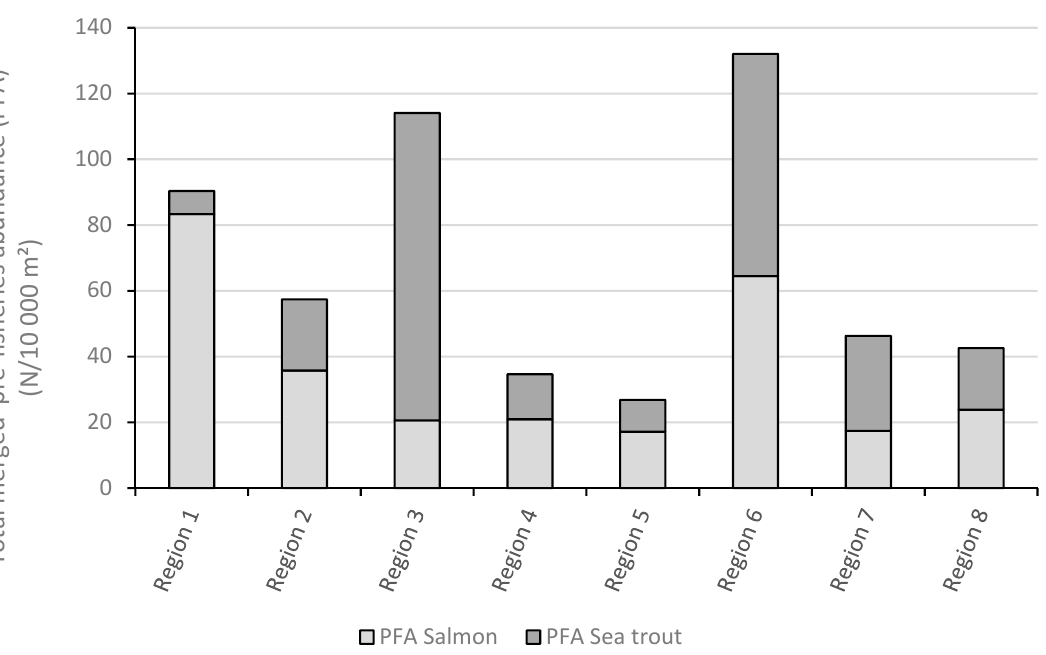
Figure 4. Total pre-fishery abundance (PFA), corrected for river area and smolt age merging data, for Atlantic salmon and anadromous brown trout (sea trout) in the eight studied regions in 2019.